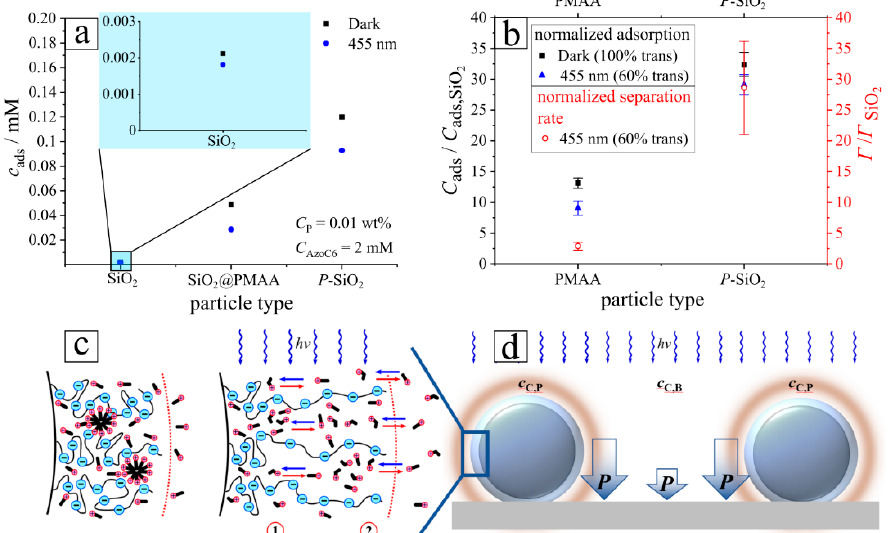
Figure 4. ( a ) Amount of adsorbed surfactant by three different particle types in dark (black points) and under illumination with blue light ( I = 10 mW/cm 2 , blue points). Surfactant concentration is fixed to 2 mM and particle concentration at 0.14 mg/mL. ( b ) Relative adsorption normalized to plain particles (SiO 2 ) ( ■ no illumination, ▲ blue light); red dots: average relative particle separation. ( c ) Cartoon of possible interaction mechanism: left, no illumination; right, under blue light. ( d ) Cartoon of l -LDDO flow generation. “P” indicates osmotic pressure distribution.